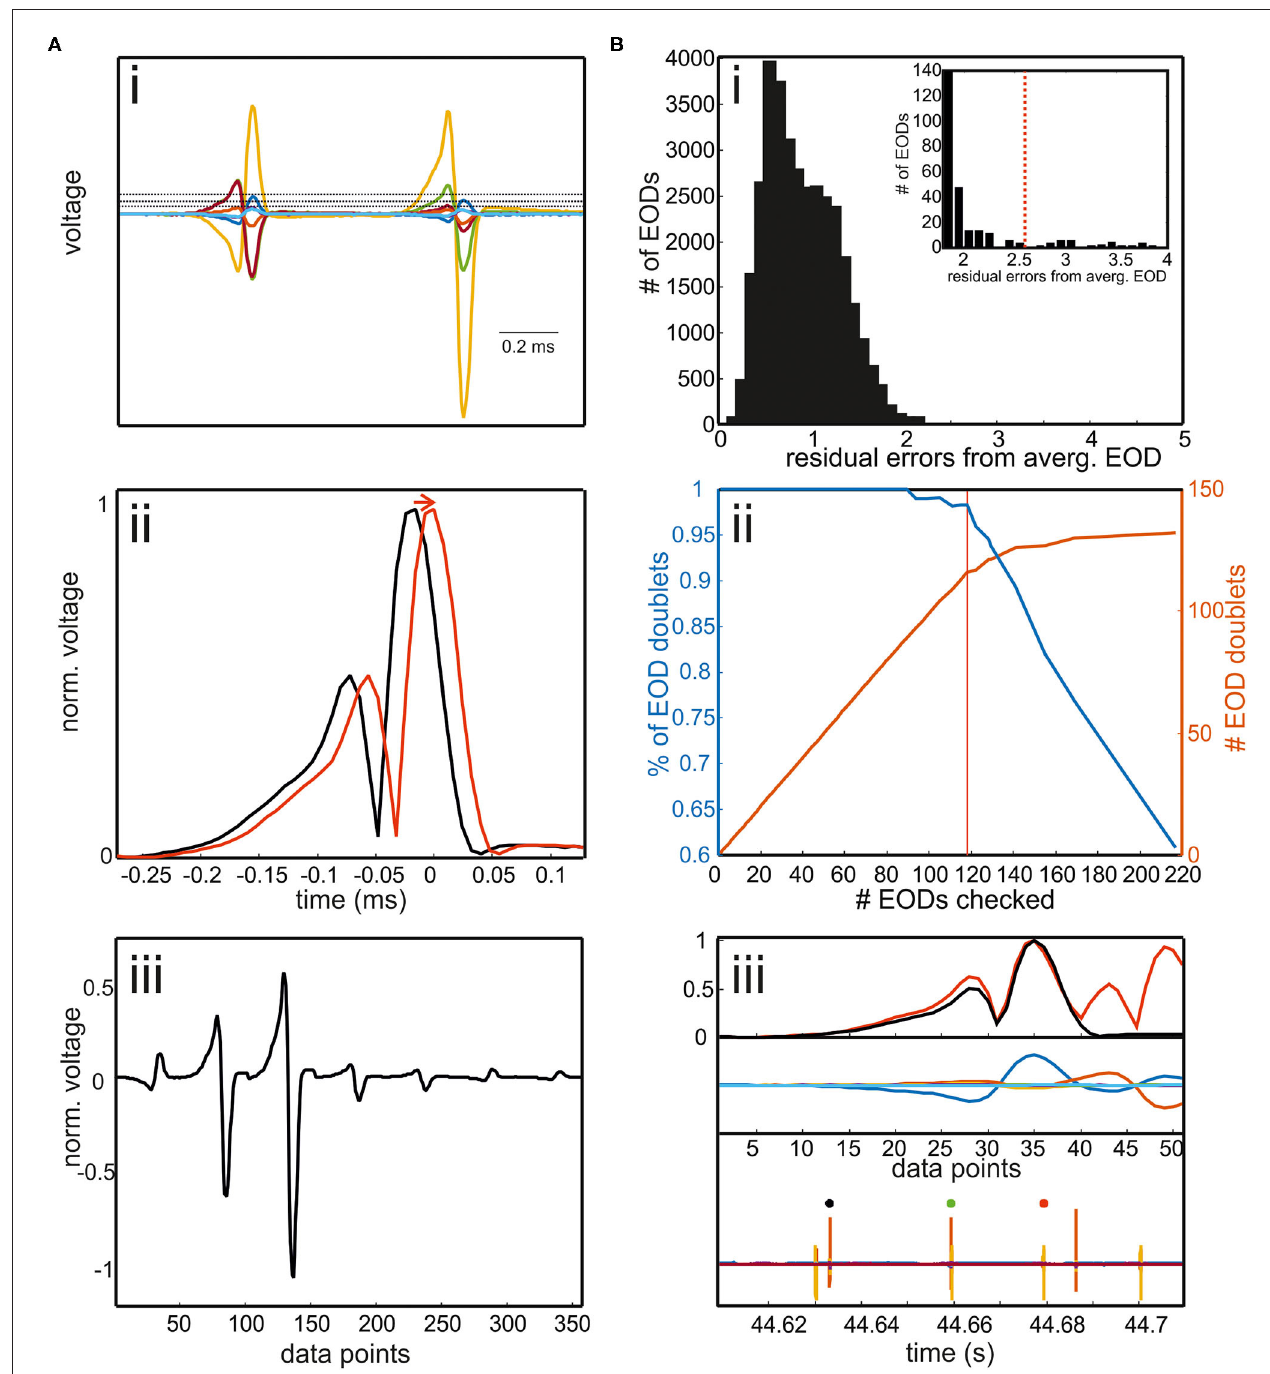
FIGURE 3 | (A) Extracting EOD input vector for the RFR model. (i) EODs were extracted by a threshold operation. The threshold was defined differently for each channel. It could be set way above noise level as EODs had to be detected only in one of seven electrode recordings. If two EODs were separated in time by less than 400 µ s, the later EOD was deleted. Interfering EODs of two fish were detected in an additional step. (ii) To align EODs, we took the absolute values and averaged across all electrodes. EODs were cut 272 µ s before and 128 µ s after the EOD peak. (iii) The concatenated EODs were stored as a vector. (B) Detection of interfering EODs. (i) Histogram of the residual errors of single EOD waveforms from an average EOD waveform. EODs were normalized to the absolute maximum peak beforehand. Inset: enlargement of the histogram including the threshold above which EOD waveforms were checked. (ii) Percentage of EOD doublets of the total number of EODs checked (blue) and the absolute number of EOD doublets found (red) plotted against the number of EODs checked. With the threshold shown in red in the inset in [ B(i) ], 119 EODs needed to be inspected. Of these 98% are doublet EODs, which accounts for almost 90% of all doublets in the data set. Thus, the manual re-analysis can be made very efficient by concentrating on this “suspicious” fraction of the total data. (iii) Example of two overlapping EODs. EOD doublet can be easily identified by visual inspection. Upper panel: normalized average EOD waveform (black) and single EOD waveform (red); middle panel: EOD recordings aligned to the maximum peaks. Lower panel: EOD recordings including the EOD detection surrounding the current “doublet” EOD (green).